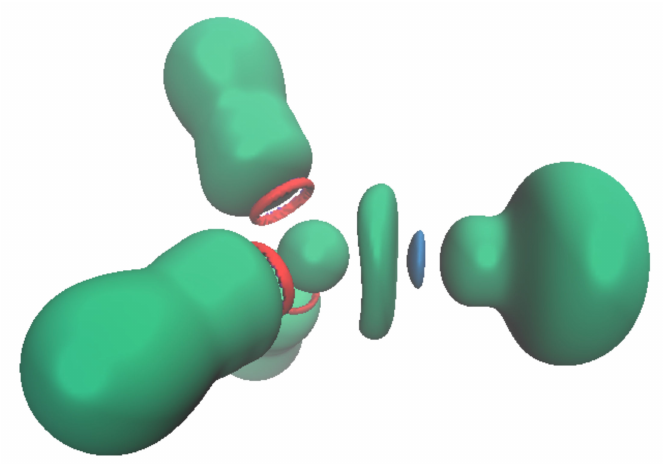
Figure 6. Topology of the [Pb(CN) 3 (HCl)] − complex. The ELF basin (isovalue η = 0.6) is shown in green; the NCI (isovalue η = 0.552) interactions are shown in red and blue. The areas in red correspond to steric repulsion and that in blue to electrostatic